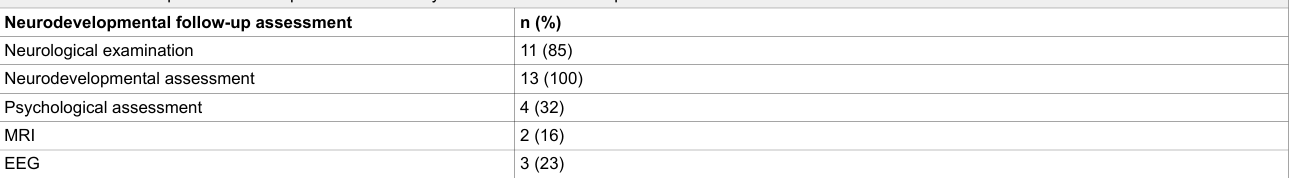
Table 2: Neurodevelopmental follow-up assessment at 2 years in thirteen follow-up centres of the Network. Neurodevelopmental follow-up assessment Neurological